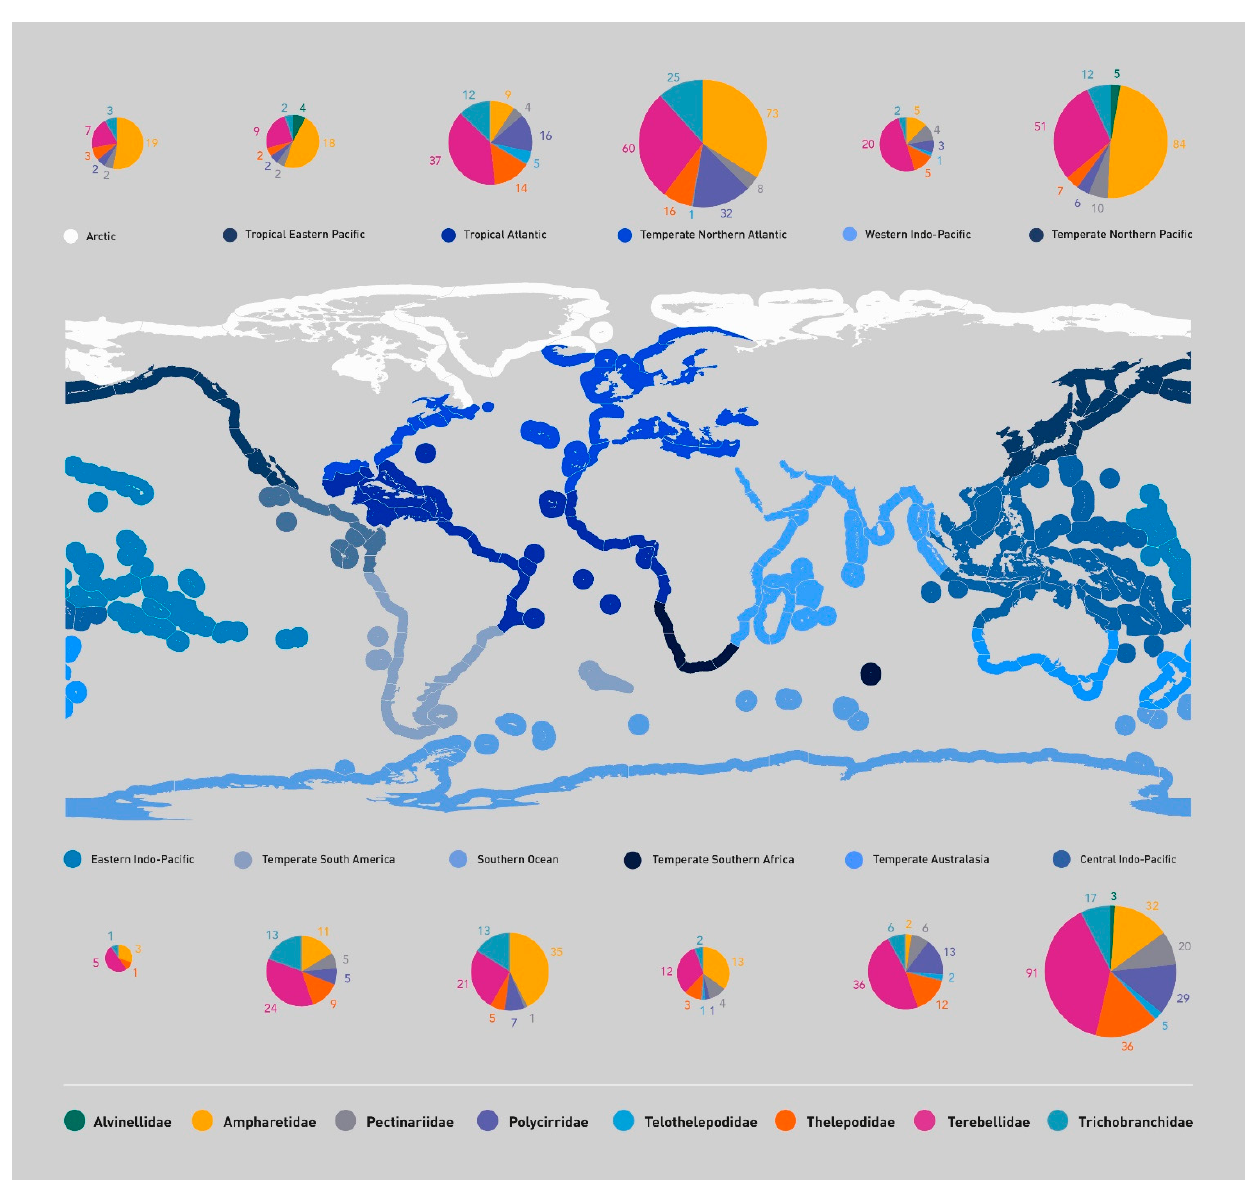
Figure 8. Marine Ecoregions of the World following [10] with number of species of terebelliforms described from each realm.